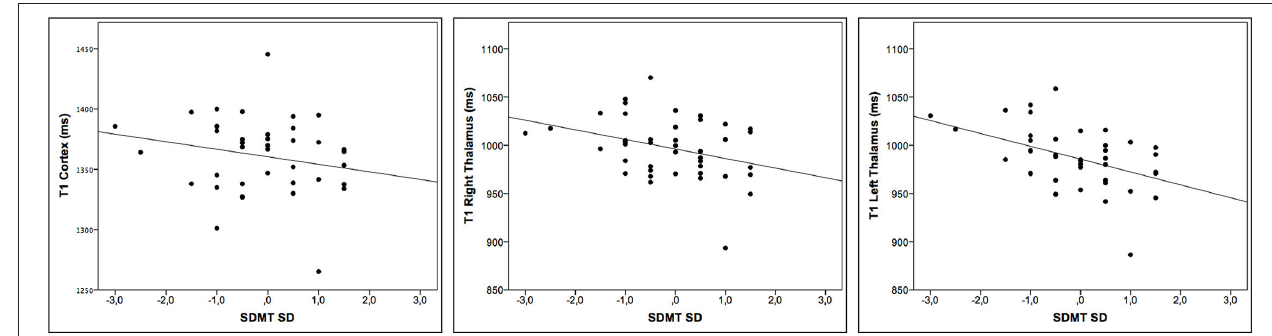
FIGURE 2 | Correlation between T1 relaxation times and cognitive impairment. Scatter plots displaying the correlation between T1-RT in the cortex, right and left thalamus, and Symbol-Digit Modalities Test (SDMT) SD to age and education matched control cohort.